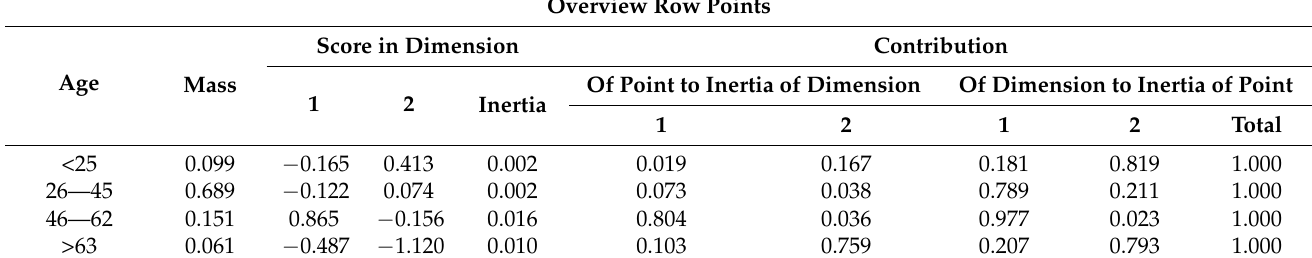
Table 3. Overview of row and column points (categories of age). Overview Row